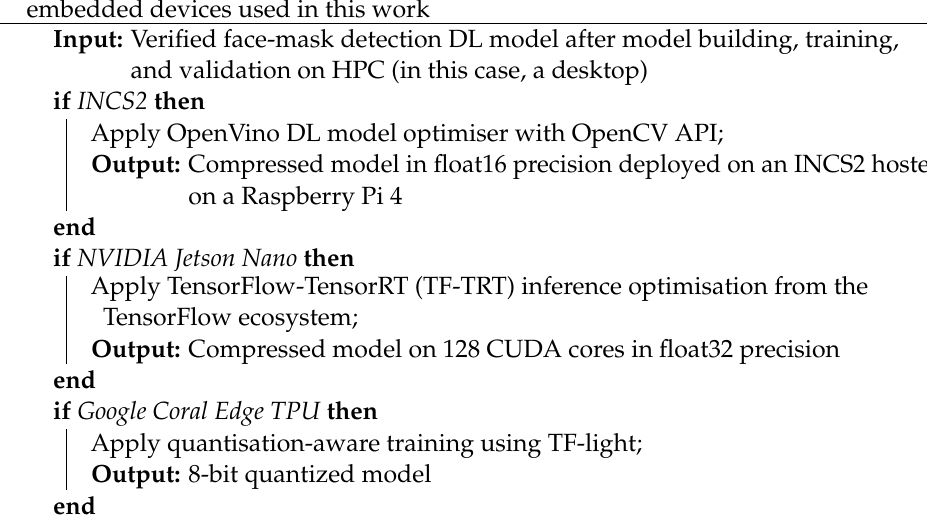
Algorithm 1: Algorithmic summary of model deployment tailored to specific embedded devices used in this